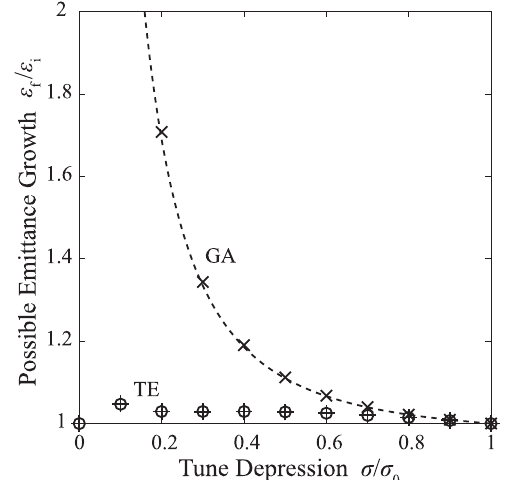
2. Possible emittance growth as a function of tune depres- sion and nonlinear field energy factor. The dashed curve and times show the estimation results for Gaussian distribution (GA) with and without constant radius ratio approximation. Circle and plus show the estimation results for thermal equilibrium distribution (TE) with and without constant radius ratio